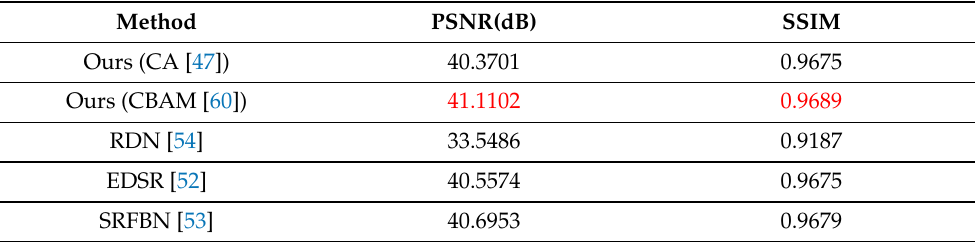
Table 7. Comparison of different attention modules in supervised manner on PROBA-V dataset. The best results are marked in